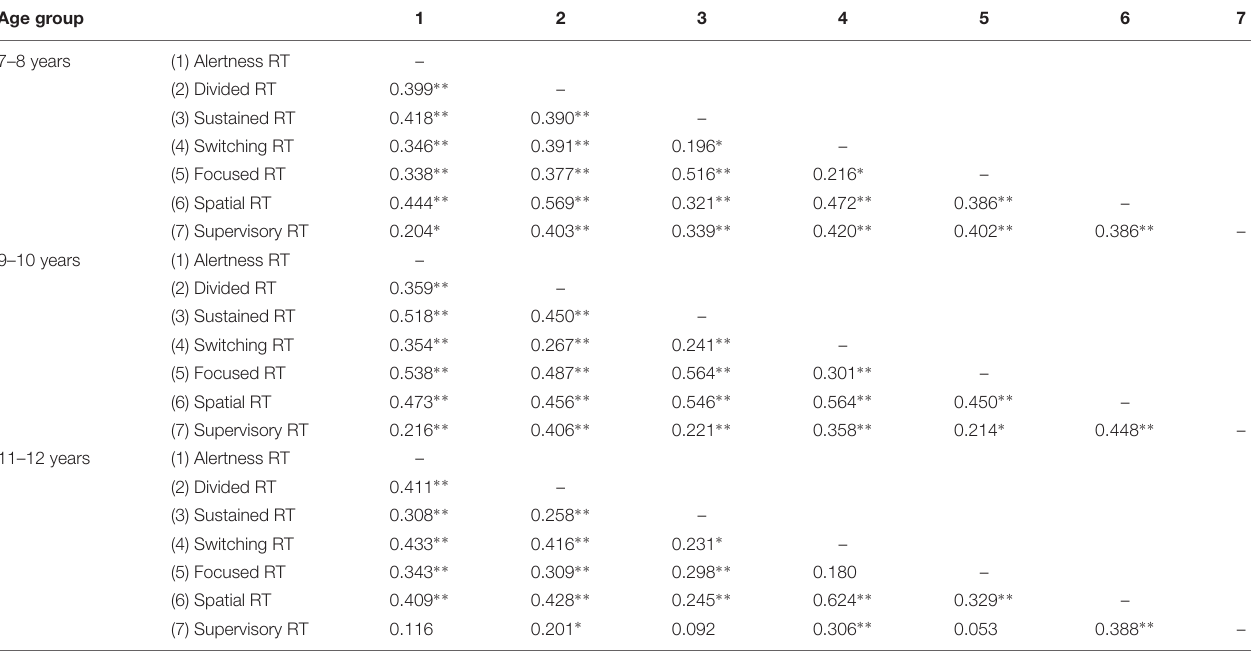
TABLE 4 | Correlations among reaction times in the seven tasks among the three age groups. Age